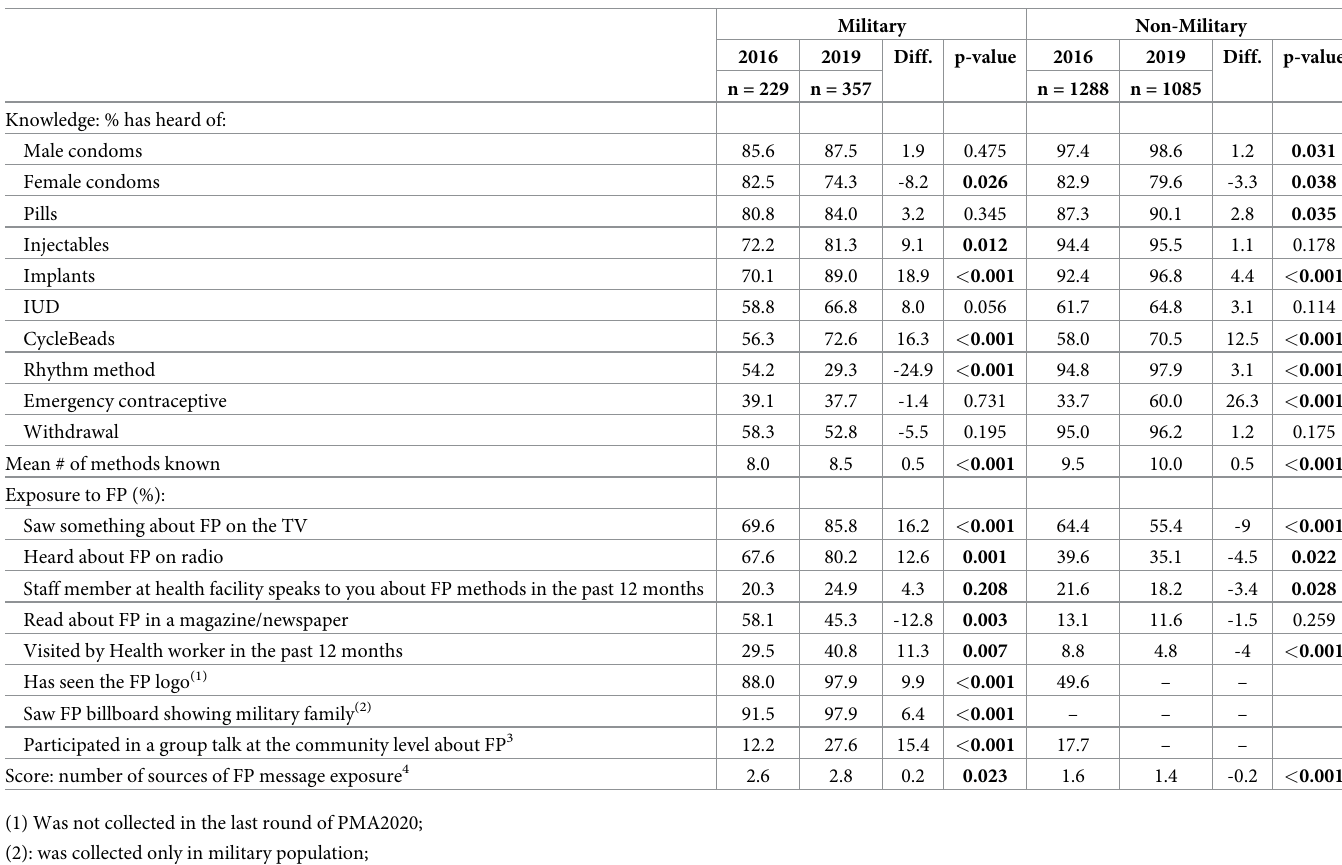
Table 2. Knowledge of contraceptive methods and exposure to FP programming among women married or in union, by type of population and year of